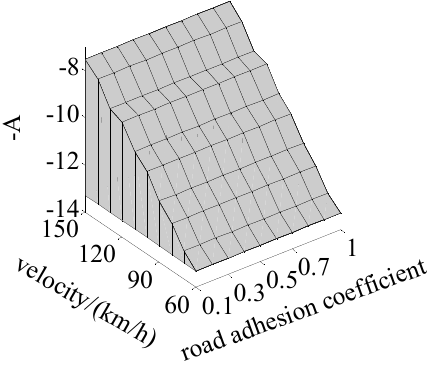
Figure 3. The map for the boundary-line inclinations.